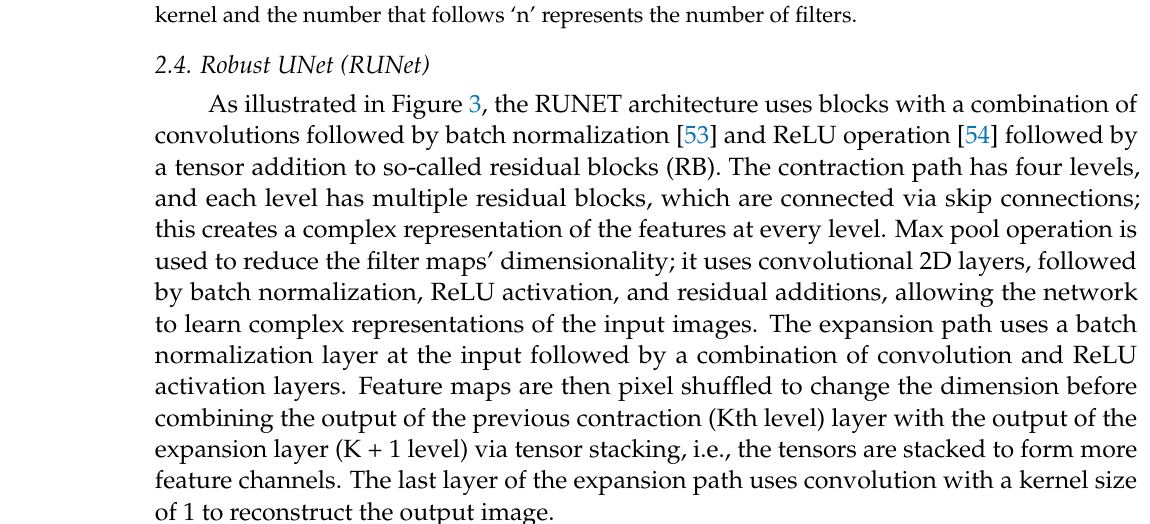
Figure 3. Robust UNet (RUNet) architecture. The number that follows ‘k’ represents the size of the kernel and the number that follows ‘n’ represents the number of filters.